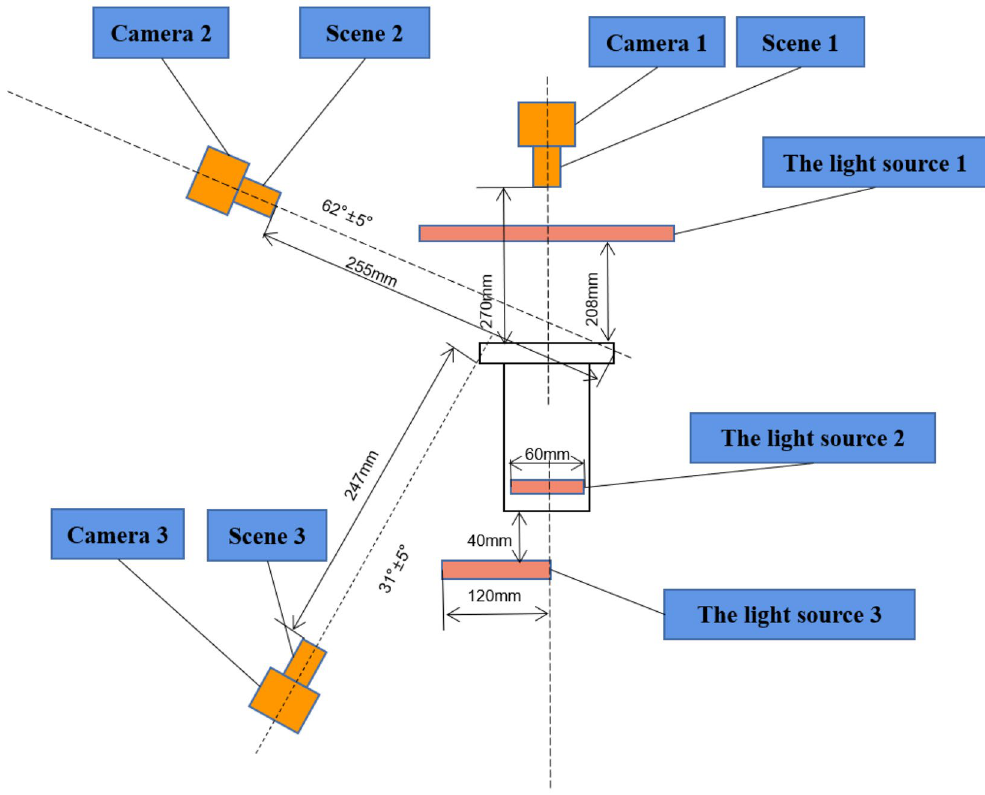
Figure 2. The structure of data collection for cylinder liner defects. Best viewed in color.